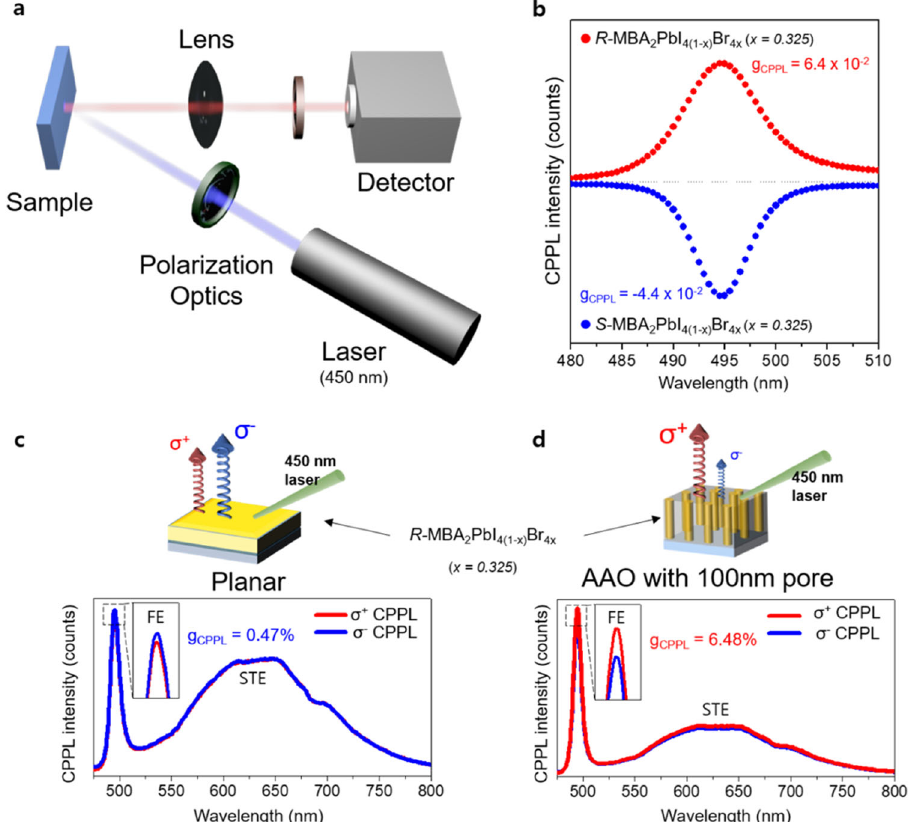
Fig. 4 Effects of asymmetric hydrogen-bonding interaction on the electronic structure of chiral 2D OIHPs. a Schematic illustration of optical setup for measuring the CPPL of chiral 2D OIHPs thin fi lms. b Magni fi ed CPPL spectra (near FE emission wavelength region) of R -MBA 2 PbI 4(1 − x ) Br 4 x chiral 2D OIHPs ( x = 0.325) grown in the AAO template with a 100 nm pore size. Full range of CPPL spectra (including FE and STE emission wavelength region) of R -